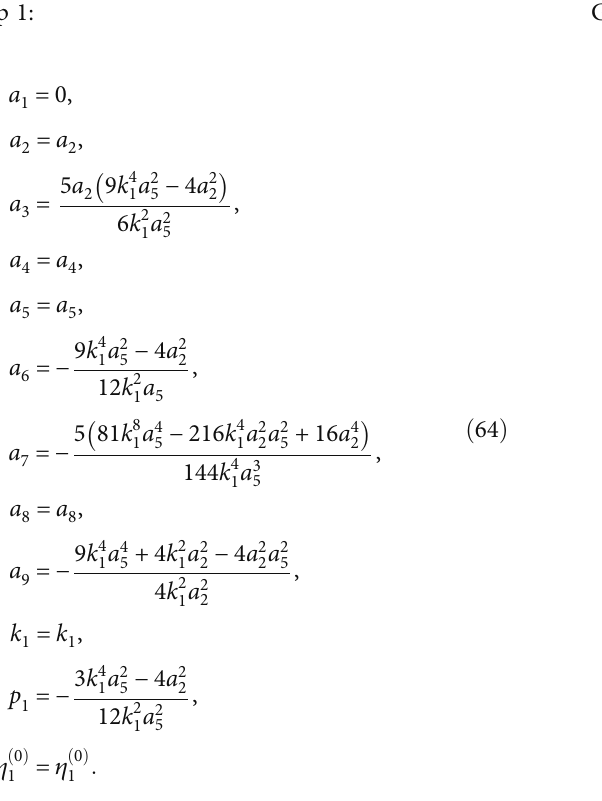
= 1, p = 3/2, and η ð 0 Þ 3 3